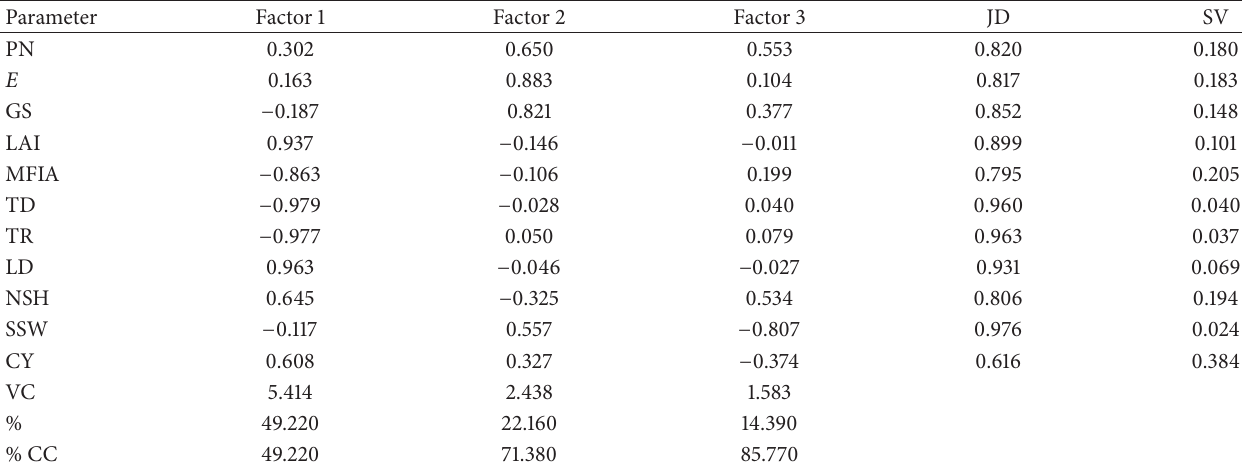
Table 6: Loading matrix of characters initial factor in sugarcane